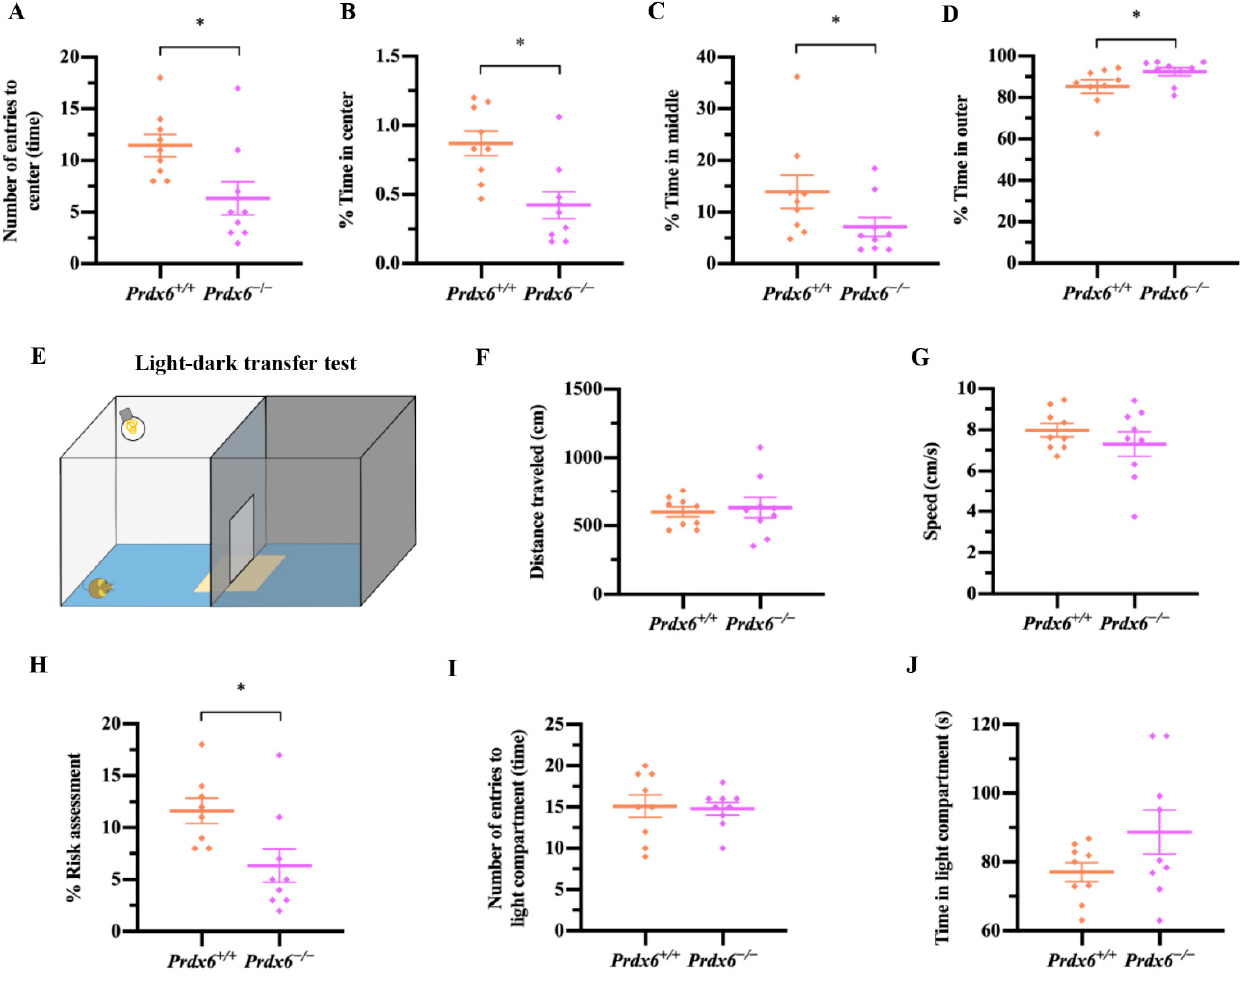
Figure 3. Female Prdx6 − / − mice exhibit high levels of anxiety-like behavior. ( A ) Number of entries into the center of an open field arena ( Prdx6 +/+ , n = 9 and Prdx6 − / − , n = 9). Percentage of time spent in ( B ) center, ( C ) middle, and ( D ) outer areas in the open field arena. ( E ) Schematic diagram of light/dark transfer test. ( F ) The traveling distance and ( G ) moving speed in the light compartment. ( H ) Percentage of risk assessment during 10 min of exploration period. ( I ) The number of entries into the light compartment. ( J ) Time spent in the light compartment. All data are presented as mean ± SEM, * p < 0.05. PRDX6, peroxiredoxin 6.